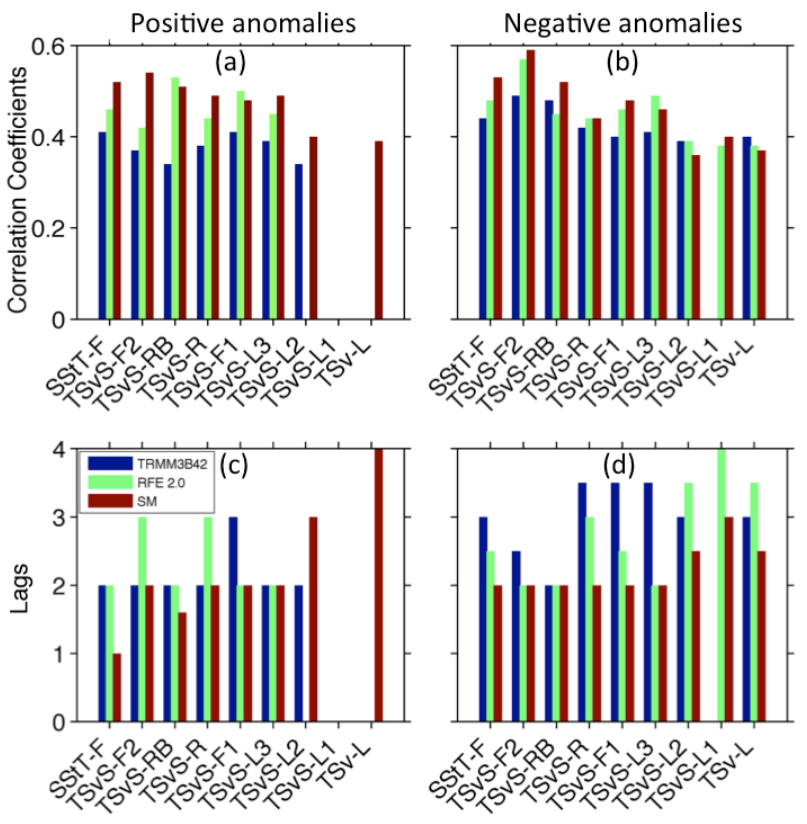
Figure 9. Comparison of correlation coefficients and lags in number of weeks between anomalies of rainfall and SM, and anomalies of LAI (TRMM3B42/LAI (blue) and RFE/LAI (green) and SM/LAI (red)) over the period 2000-2010 and on all the VSZs (see Table 3 for legend items) in the Ferlo watershed; with ( a ) correlation coefficients between positive anomalies; ( b ) correlation coefficients between negative anomalies; ( c ) lags between positive anomalies and ( d ) lags between negative